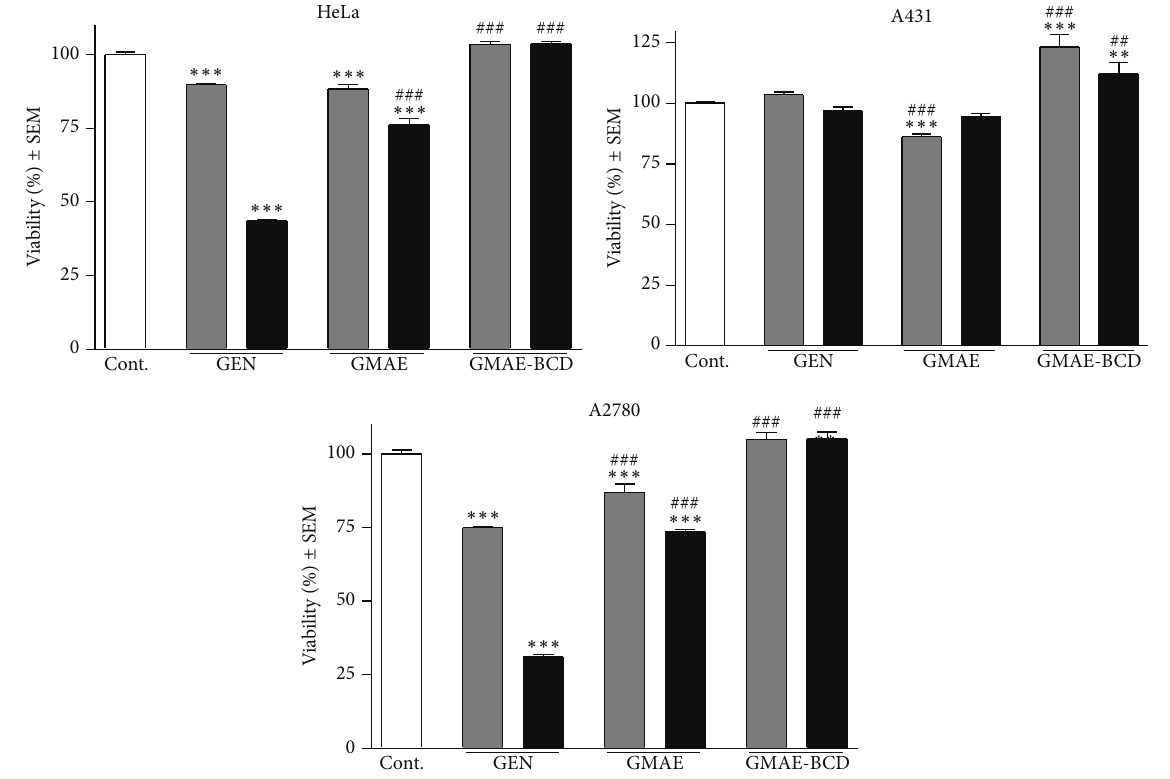
Figure 4: Viability of selected cells after incubation with 10 𝜇 M (gray) or 30 𝜇 M (black) of GEN, GMAE, and GMAE-BCD. ∗∗ and ∗ ∗ ∗ indicate 𝑝 < 0.01 and 𝑝 < 0.001 , respectively, as compared with the control cells. ## and ### indicate 𝑝 < 0.01 and 𝑝 < 0.001 , respectively, as compared with the cells treated with the corresponding concentration of